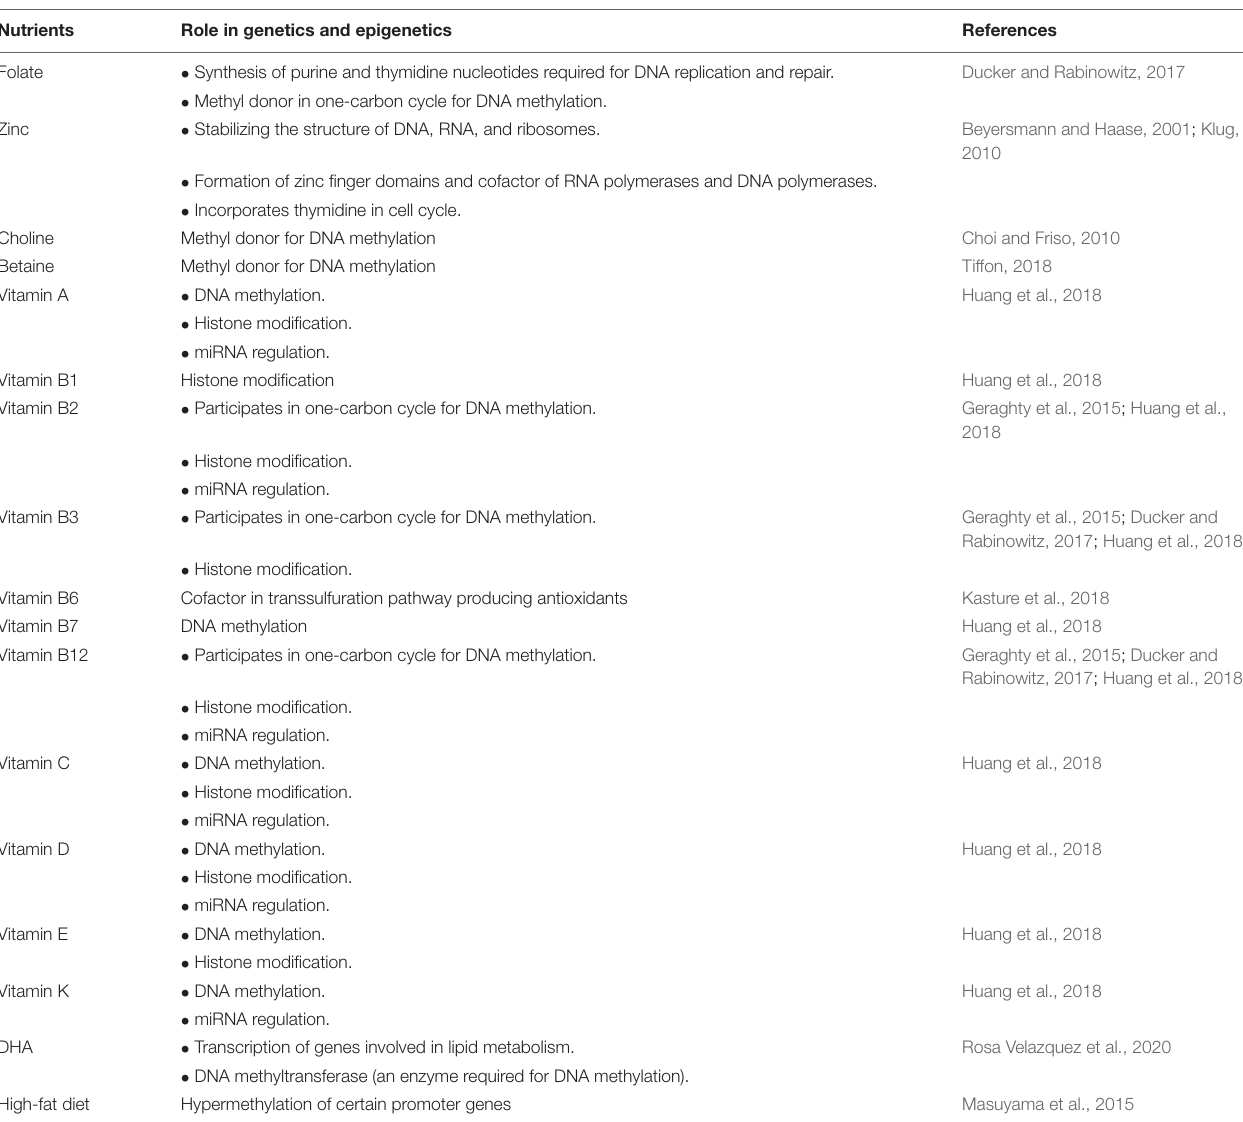
TABLE 4 | Role of nutrients in genetics and